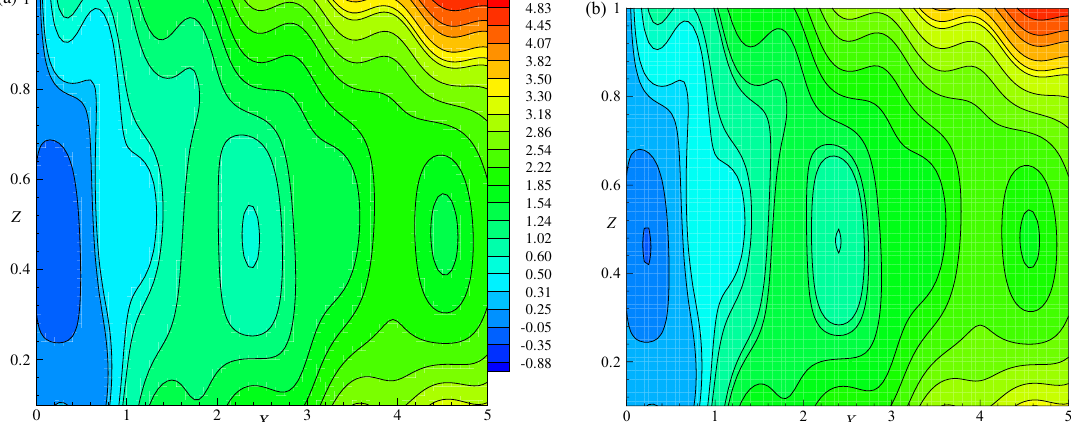
Figure 16. Heatlines for Le = 0.05 ( a ) and 0.06 ( b ) at ψ = − 0.03, χ = 0.2, t = 0.8 and R = 3 R co .